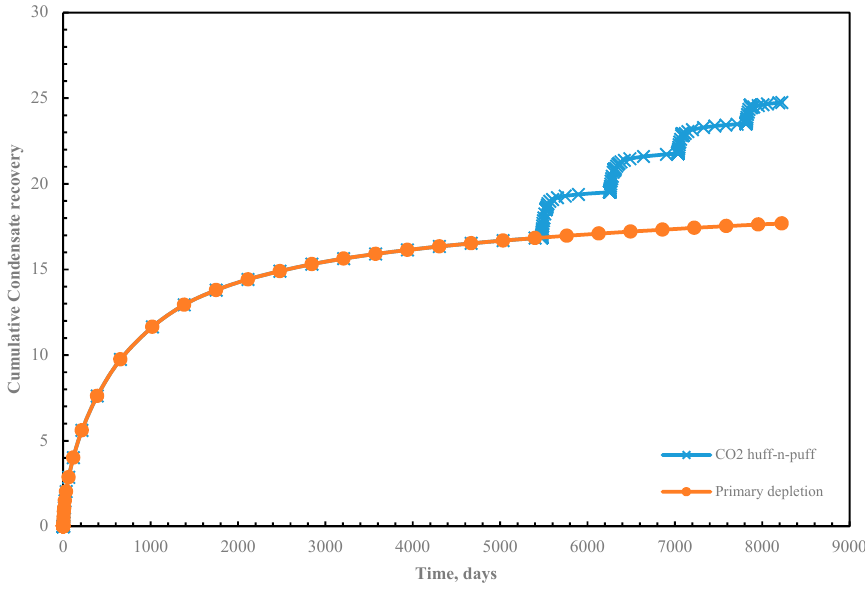
Figure 11. Comparison of cumulative condensate recovery.